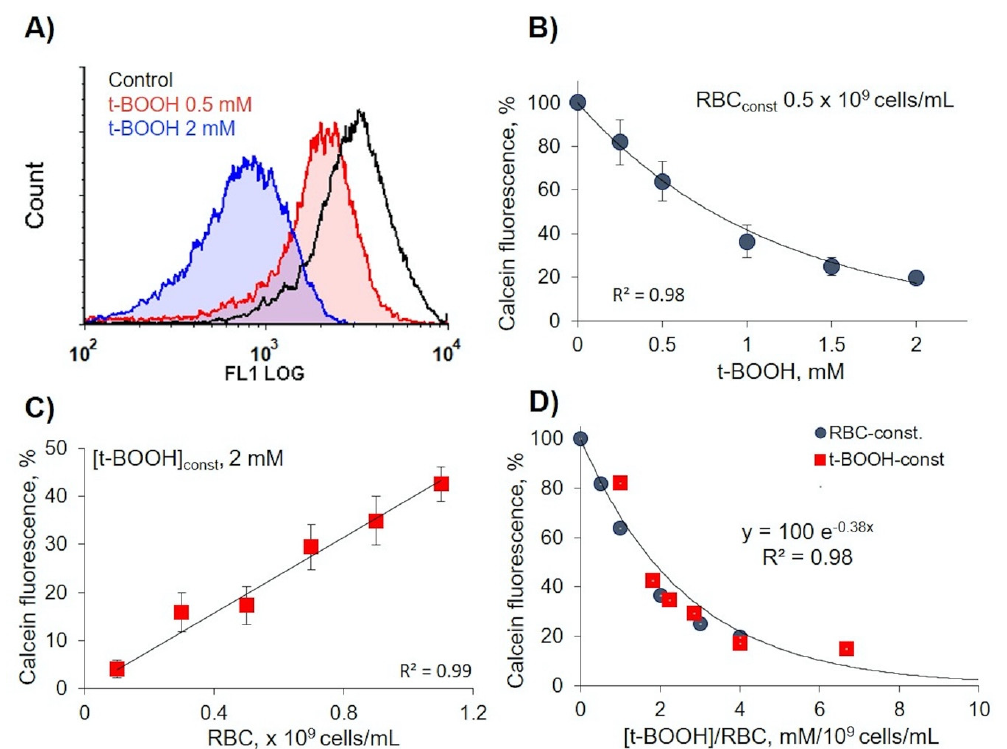
Figure 1. Calcein fluorescence intensity strongly depended on oxidant to cell count ratio. Red blood cell (RBC) suspension was incubated with tert -Butyl hydroperoxide (t-BOOH) at indicated concentrations for 1 h, then RBCs were stained with calcein-AM (5 µ M, 40 min) and analyzed for calcein fluorescence intensity by flow cytometry at FL1 (logarithmic scale). ( A ) Representative histograms from five independent experiments. ( B ) Dependence of calcein fluorescence intensity in constant RBC count from t-BOOH concentrations. ( C ) Dependence of calcein fluorescence intensity in constant t-BOOH concentration from RBC count. ( D ) Exponential dependency between calcein fluorescence intensity and the ratio of oxidant concentration / cell count ([t-BOOH] / RBC). Data in ( B , C ) are presented as means ± SD, n = 5.